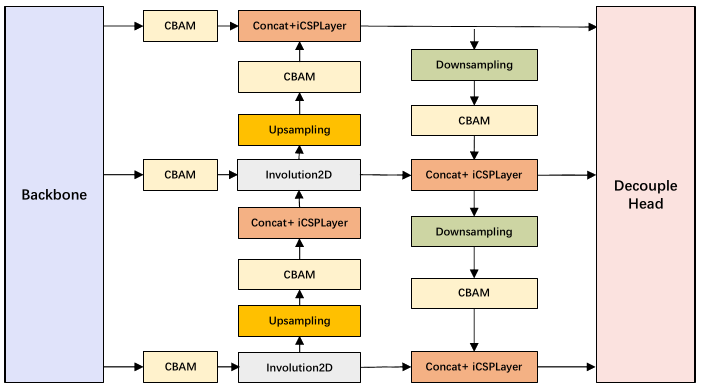
Figure 6. iPANet structure diagram. CBAM is convolutional block attention module. Involution2D is two-dimensional involution layer. Concat means stacking channels together.